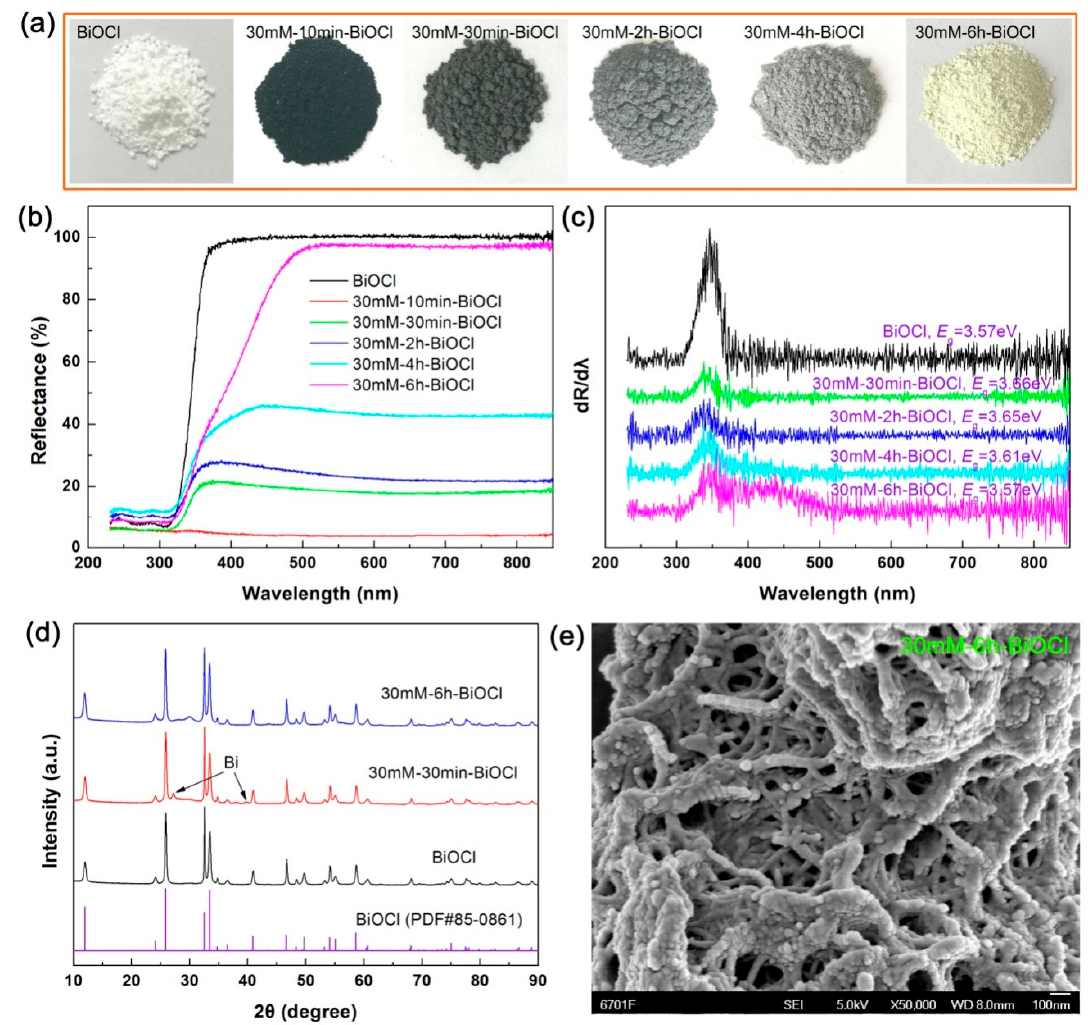
Figure 10. ( a – d ) Apparent colors, UV-vis di ff use reflectance spectra, first derivative curves of the UV-vis di ff use reflectance spectra, and XRD patterns of the 30 mM NaBH 4 -treated BiOCl samples with di ff erent treatment times, respectively. ( e ) SEM image of 30mM-6h-BiOCl.